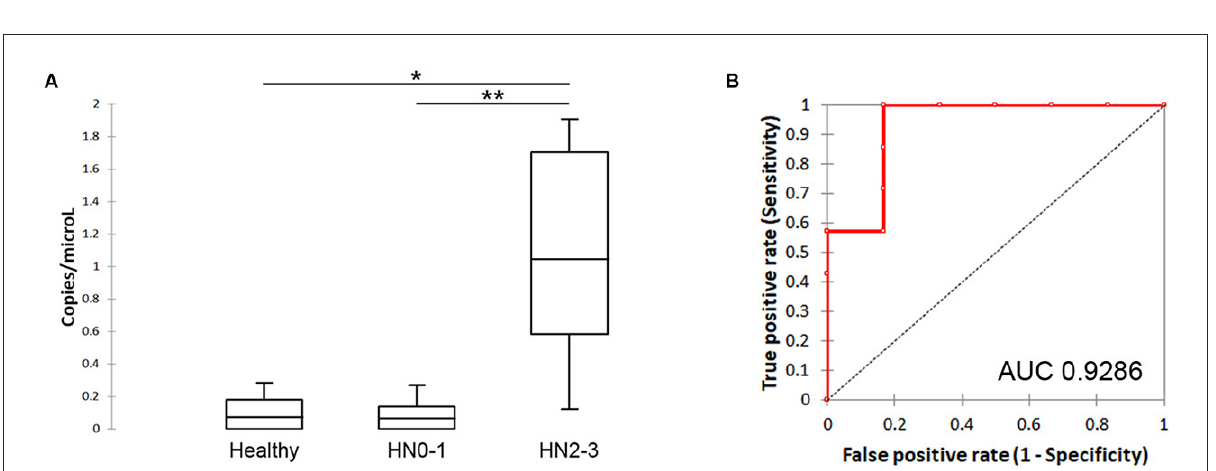
FIGURE2 Quantification of sEV-miR-21-5p and evaluation of its ability to discriminate the metastatic patients. (A) Box plot of sEV-miR-21-5p in healthy and MCT-affected dogs without (HN0-1) or with (HN2-3) nodal metastasis. (B) Performance of sEV-miR-21-5p as a candidate biomarker for discriminating MCT-affected dogs without (HN0-1) or with (HN2-3) nodal metastasis. Receiver-operator characteristic (ROC) curve analysis. AUC, area under the curve.